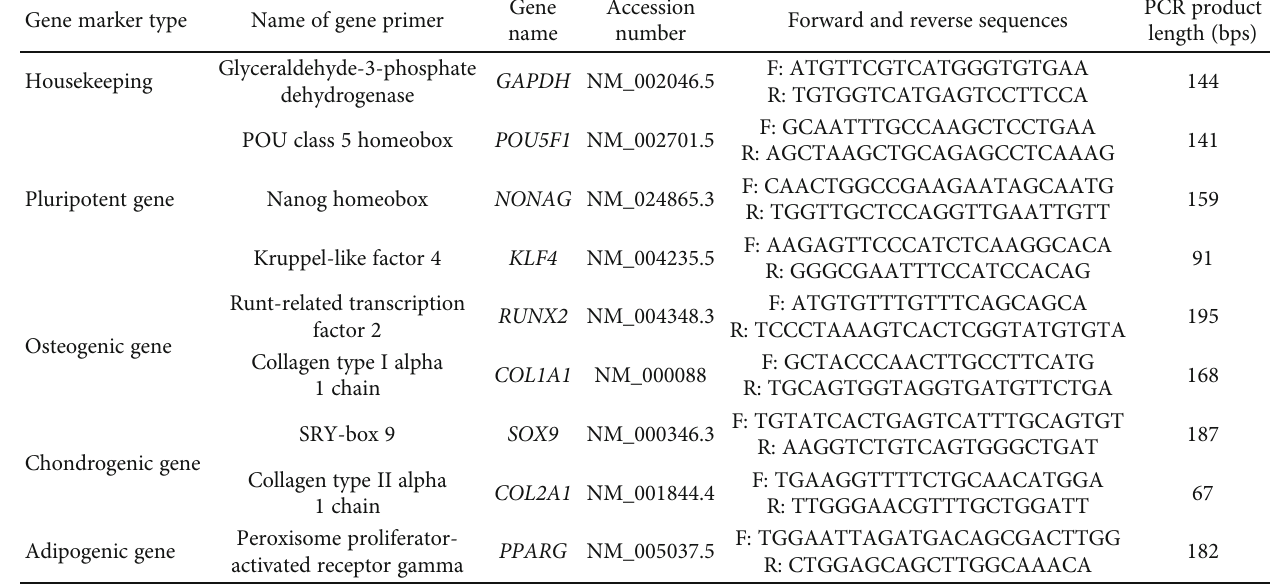
Table 1: The information of the speci fi c